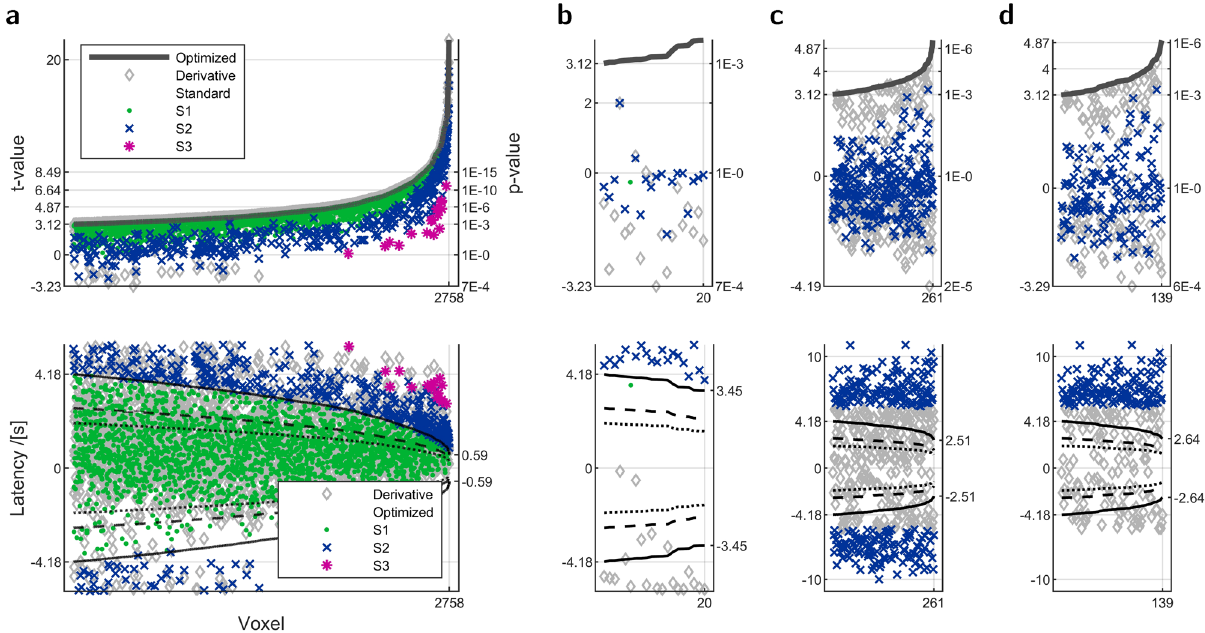
Figure 5. Confusions of latency. Latencies close to the limits of the central ratio–latency function and beyond appear as within-limit latencies of opposite sign. The plots show voxels with optimized magnitude at significance level p < 0.001 uncorrected, sorted by ascending t-value. Top , t-value of magnitude, Bottom , Latency. ( a ) Optimized latency within ±5.5 s, ( b ) Subset of ( a ), voxels with positive latency and sign flip, ( c ) Optimized latency outside limits, ( d ) Subset of ( c ), voxels with positive latency. In the plots of t-value, markers for the subsets S1–S3 from Fig. 3 are attached to data points from standard HRF. In the plots of latency, they are attached to data points from optimization. Pairs of black lines connect the threshold latencies for significance at p < 0.05 Bonferroni corrected (solid), p < 0.001 uncorrected (dashed), and p < 0.01 uncorrected (dotted). Close ordinate values show lowest (right) and highest (left) thresholds at Bonferroni corrected p < 0.05. There, an absolute latency must have been larger than 0.59 s (0.37 s at p < 0.001 uncorrected, 0.28 s at p < 0.01